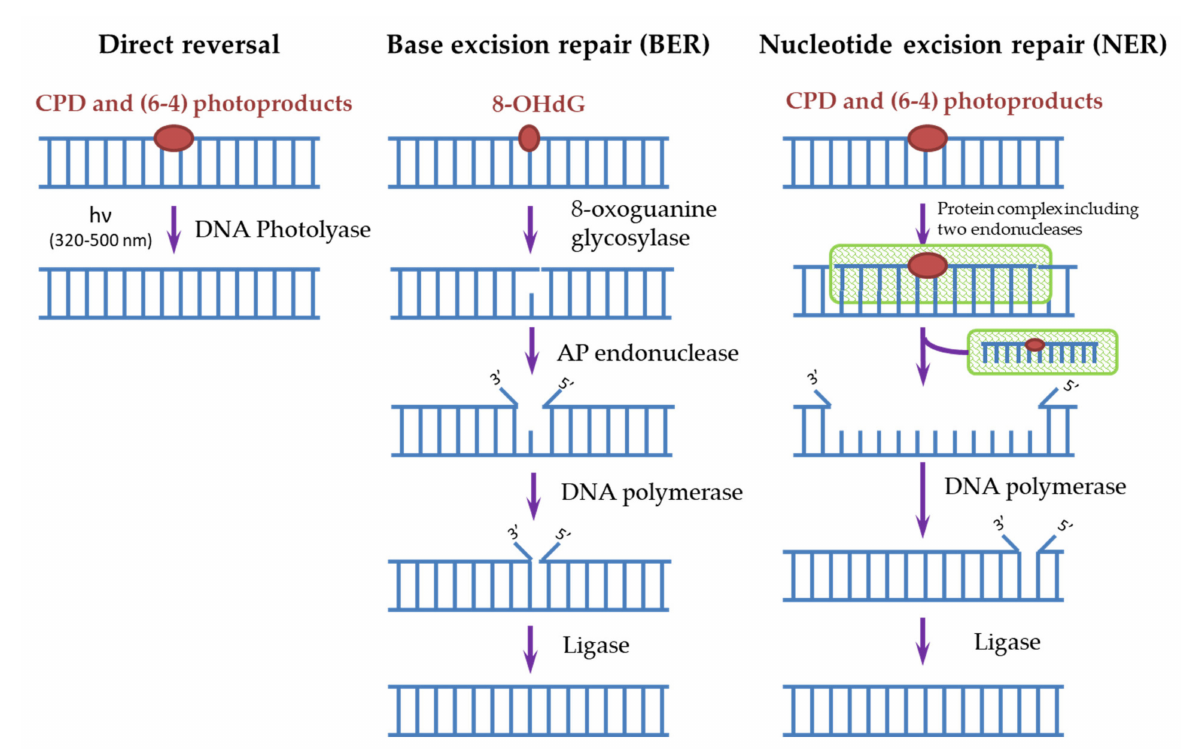
Figure 3. Scheme of direct and excisional repair in photodamaged